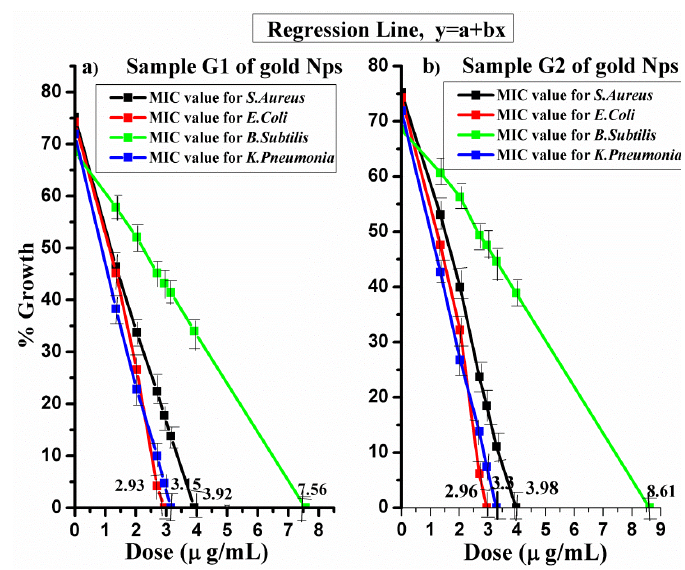
Figure 5. ( a ) Maximum inhibition concentration of sample G1 for S. aureus , E. coli , B. subtilis and K. pneumonia ; ( b ) maximum inhibition concentration of sample G2 for S. aureus and E. coli , B. subtilis and K. pneumonia according to regression line.